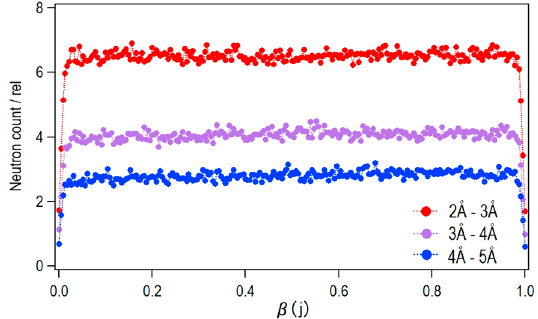
Figure 8. Neutron count efficiency along a typical PSD tube.